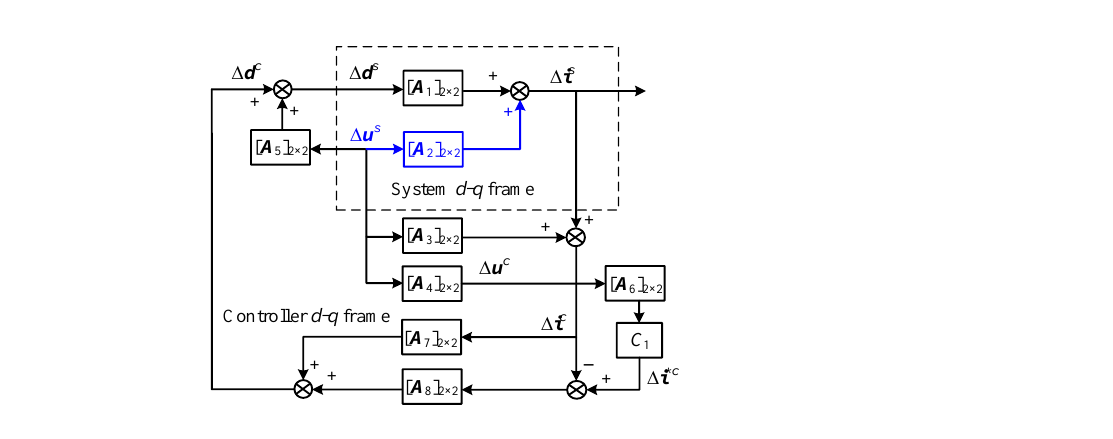
Figure 4. Small-signal model of grid-connected converter with conventional direct power control under reverse power flow.